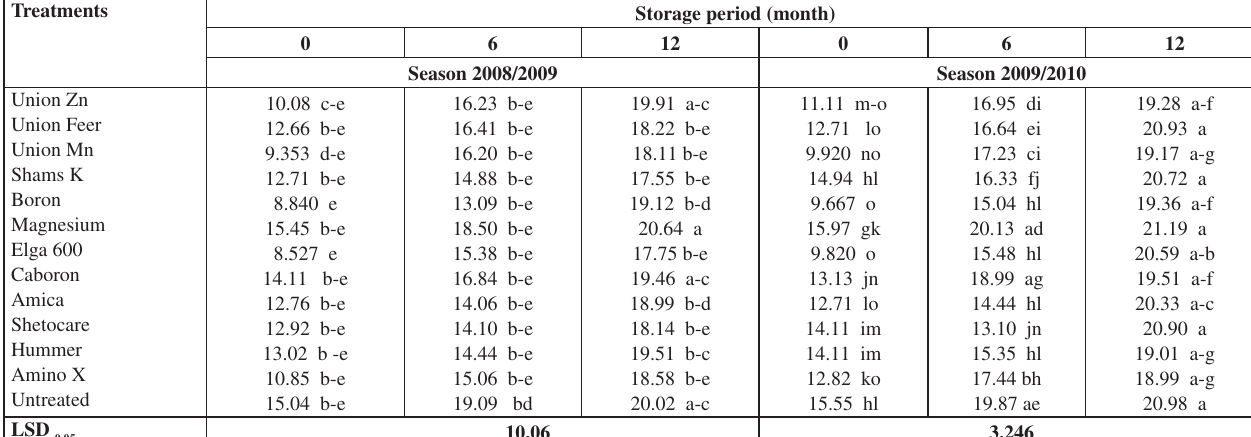
during two seasons